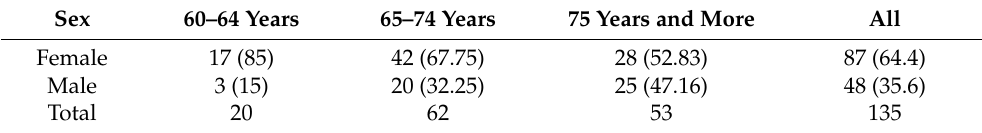
Table 1. Frequency of participants by age groups in years (relative percentage in parentheses).